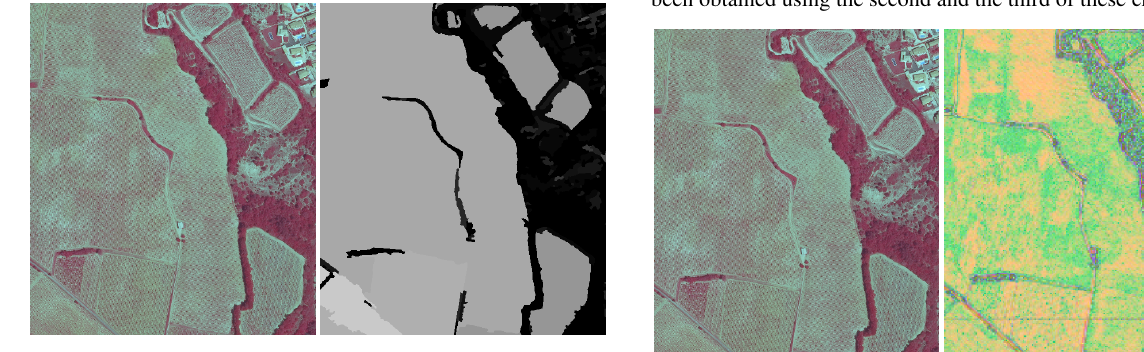
Figure 4: “Vineyard” index computed from the left image. Figure 5: The second image is a texture image obtained from SIFT descriptors extracted from the left 4 SECOND APPROACH : CLASSIFICATION USING TEXTURAL FEATURES